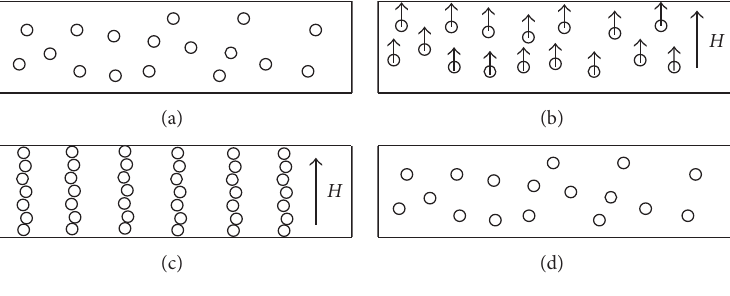
Figure 1: The chain process of MR fluid.